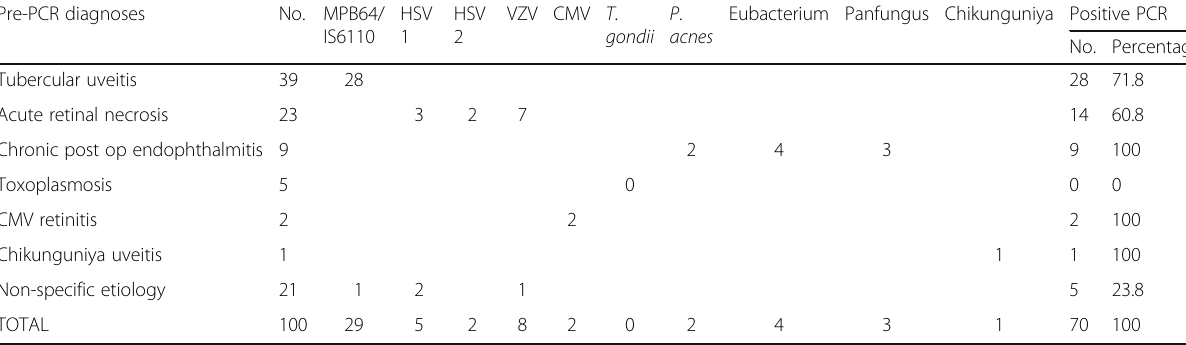
Table 2 Correlation of pre-PCR diagnosis with post-PCR results Pre-PCR diagnoses